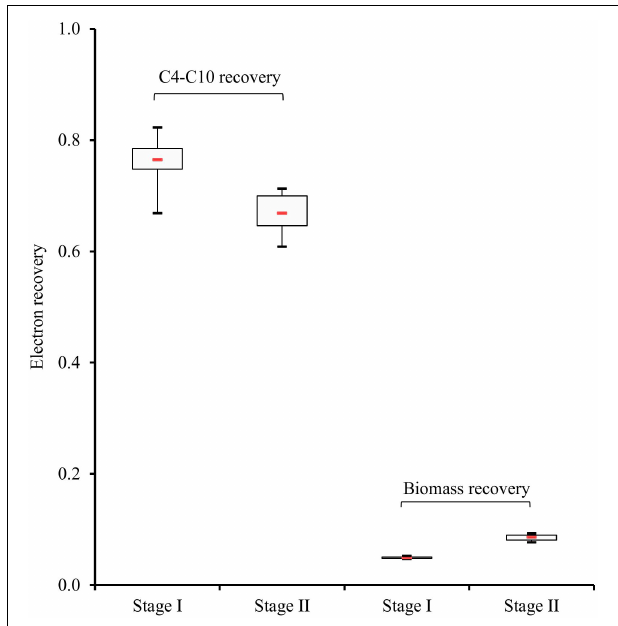
FIGURE 4 | Electron recoveries in carboxylates (C4-C10) and cell biomass, represented by 95% confidence intervals. Boxes indicate the interquartile range between the 25th and 75th percentiles, respectively, the red line inside indicates the median value, mean values between both stages show significant differences ( P <